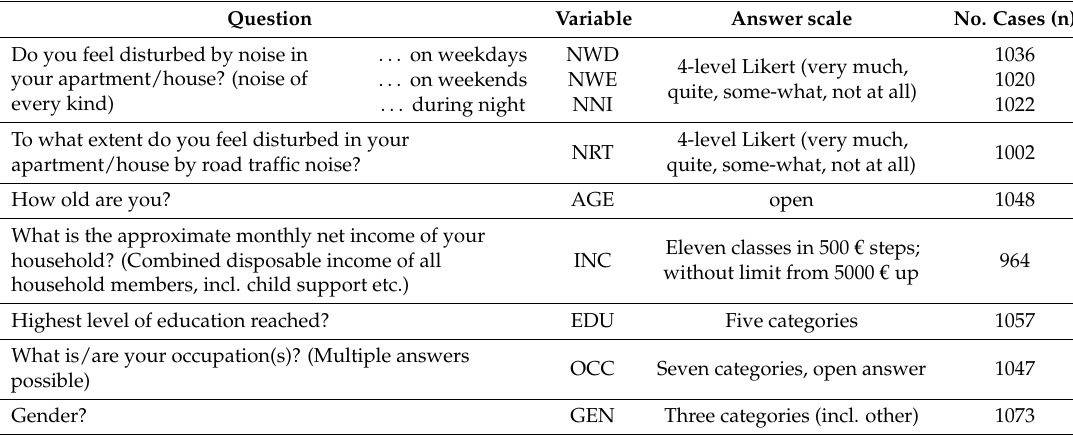
Table 1. Variables from the survey used for